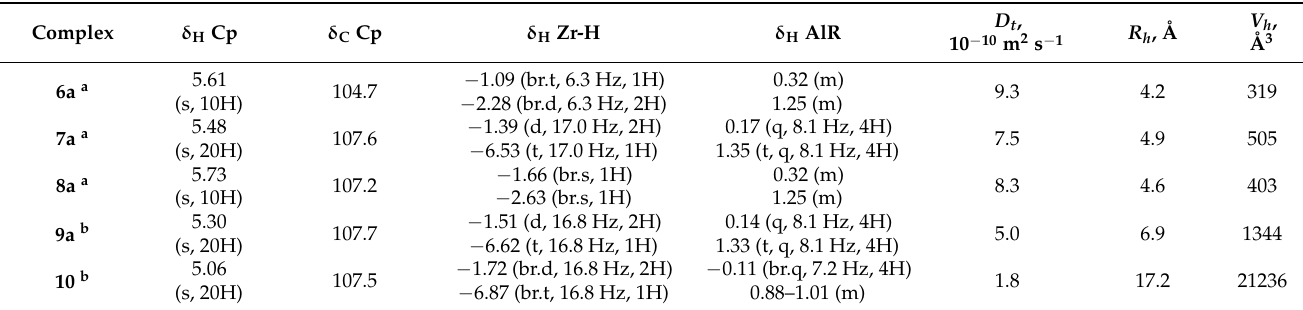
Table 2. 1 H and 13 C NMR ( δ , ppm, 400.13 MHz ( 1 H), 100.62 ( 13 C), T = 298 K), diffusion coefficients, hydrodynamic radii, and volumes of complexes 6 – 10 obtained by the diffusion ordered spectroscopy